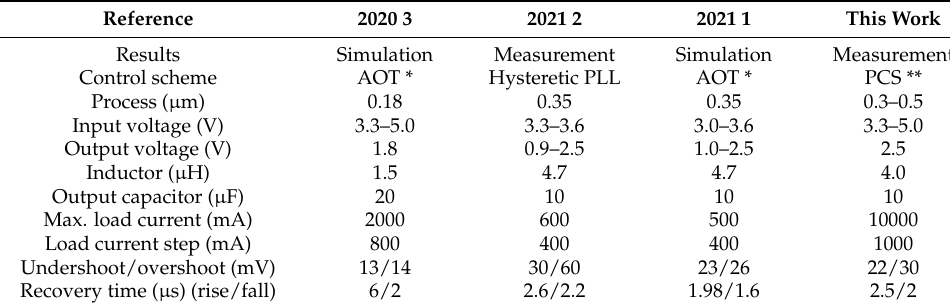
Figure 14. ( a ) Hall-effect sensor vs. single shunt + Rds(on) vs. single shunt only FFT for current waveform during current control at 700 rpm@10 A pk ; ( b ) Hall-effect sensor vs. single shunt + Rds(on) vs. single shunt only FFT for current waveform during current control at 130 rpm@5 A pk . Table 5. Performance comparisons with reported converters.